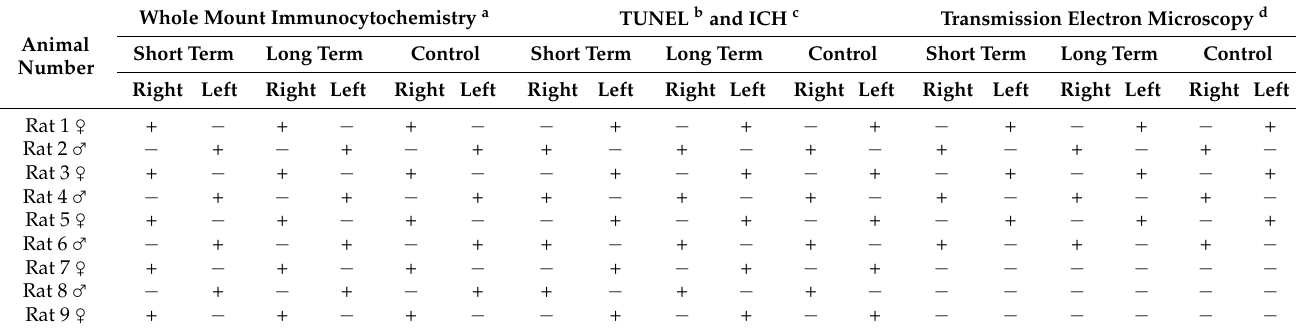
Table 1. Assignation of retinas for post-mortem